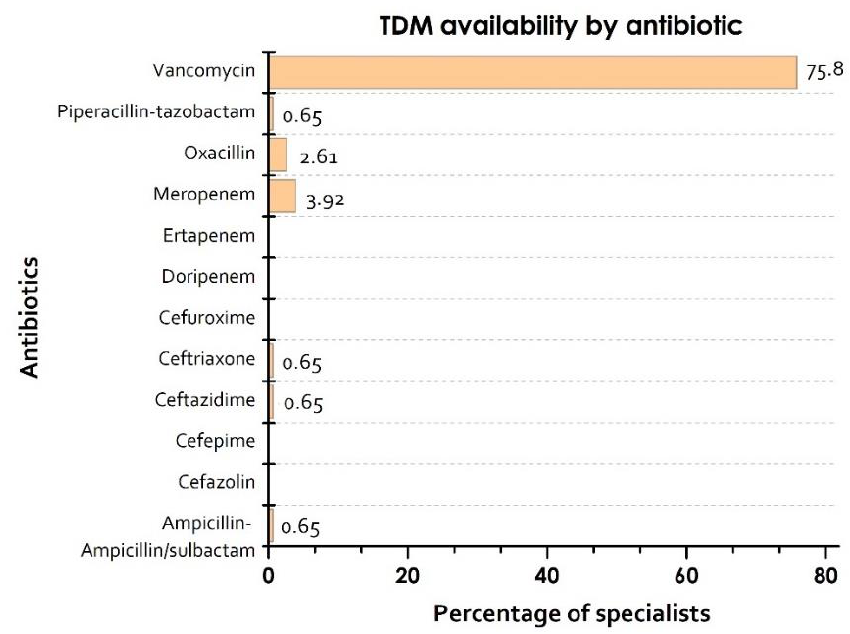
Figure 1. Antibiotics in which serum concentrations can be controlled according to availability in the hospital where the specialists work. TDM: therapeutic drug monitoring.